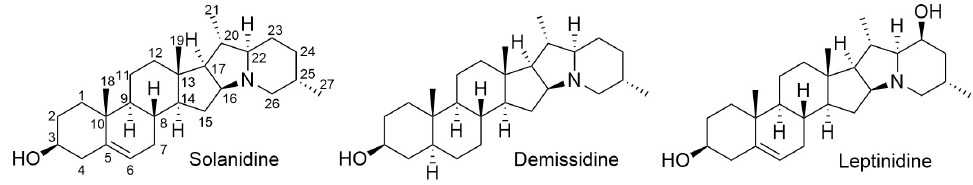
Figure 1. Steroidal alkaloids of solanidane